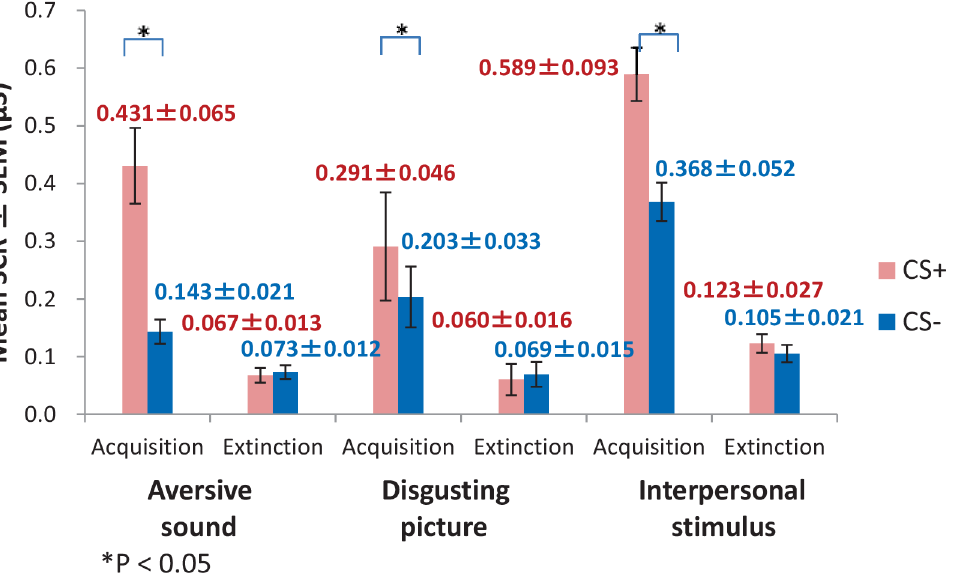
Fig 3. Mean SCR amplitudes during the acquisition and extinction phases in the three conditions. Abbreviations: SCR, skin conductance response; SEM, standard error of the mean; μ S, microsiemens